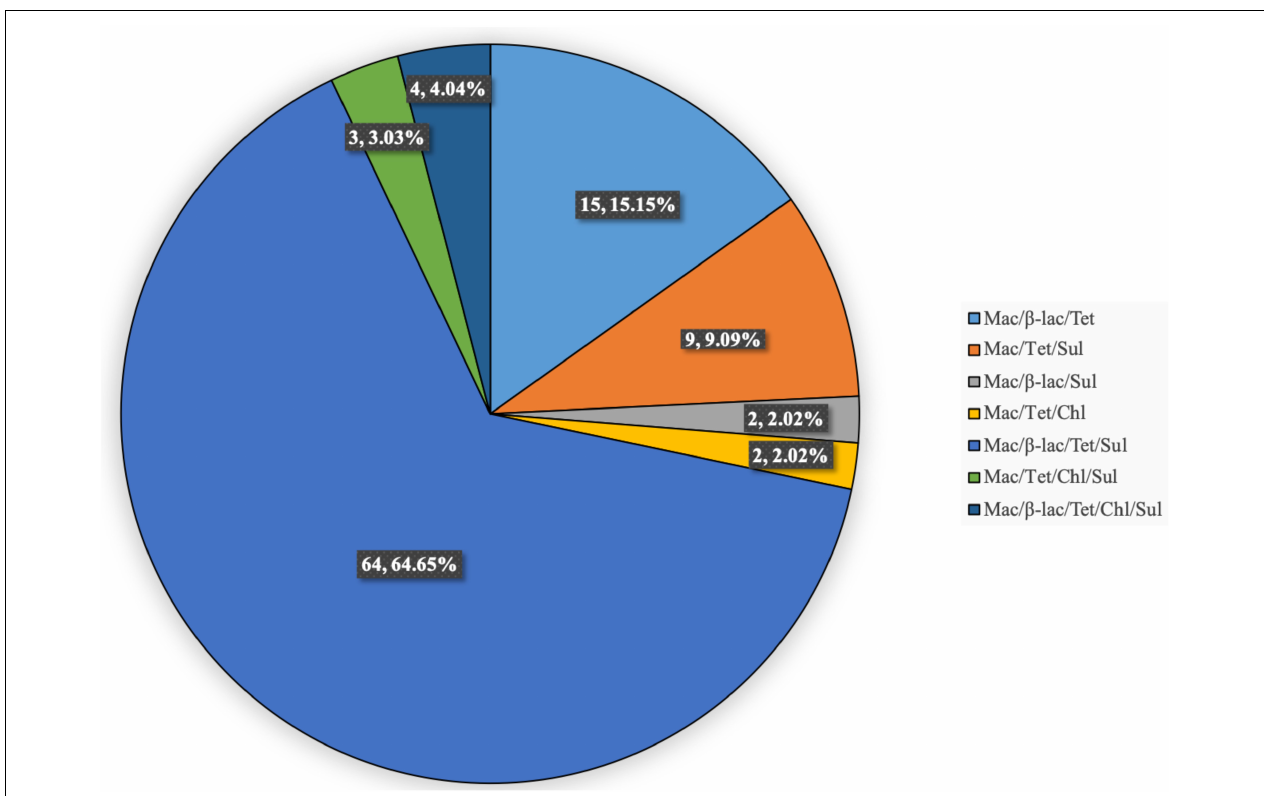
FIGURE 1 | Distribution of antibiotic-resistance patterns of MDRSP strains. Mac, macrolides; β -lac, β -lactams; Tet, tetracyclines; Sul, sulfonamides; Chl, chloramphenicols.